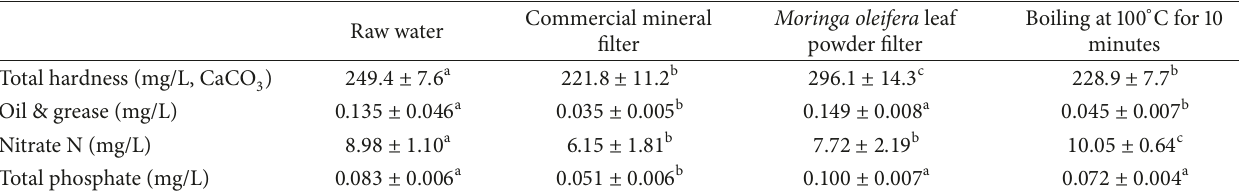
Table 2: Mean values ± SD of physicochemical parameters of raw water and treated water at each treatment. The mean values indicated by different superscript letters at each row are significantly different from each other (paired 𝑡 -test, 𝑝 < 0.05 , 𝑛 = 20